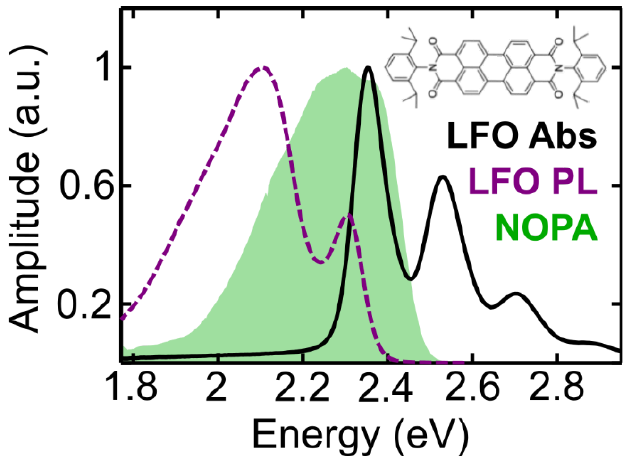
Figure 1. Static absorption (black solid line) and photoluminescence (violet dashed line) spectra of LFO in PS (10% concentration by mass), together with the laser pulse spectrum (shaded green line) obtained from the non-collinear optical parametric amplifier (NOPA) system. The inset shows the molecular structure of LFO.